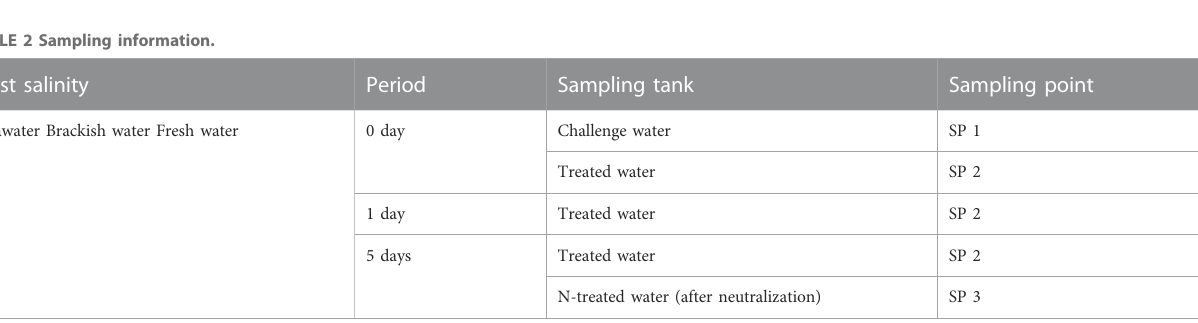
TABLE 2 Sampling